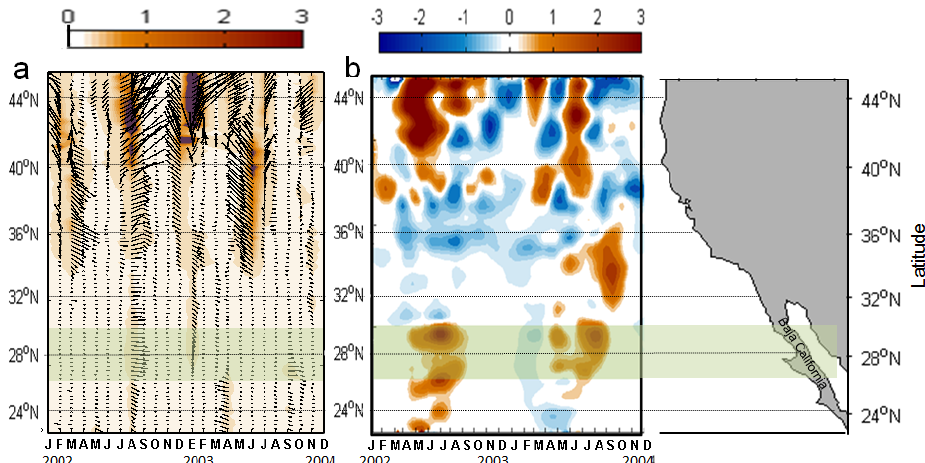
Figure 7. Hovmӧller diagrams of interannual anomalies of (a) monthly wind stress (magnitude and direction; N m -2 x 10 -2 ) and (b) weekly Chlorophyll a (mg m -3 ) from January 2002 to December 2003 along the northeast Pacific coast from 22°N to 45°N (values within 50 km of the coast), including Punta Eugenia area (shaded in green). The wind data are provided by the Cross-Calibrated Multi-Platform (CCMP) project website at http://podaac.jpl.nasa.gov/dataset/, and weekly Chlorophyll a by the SeaWiFS Project of NASA Goddard Space Fligt Center website at http://oceancolor.gsfc.nasa.gov/.